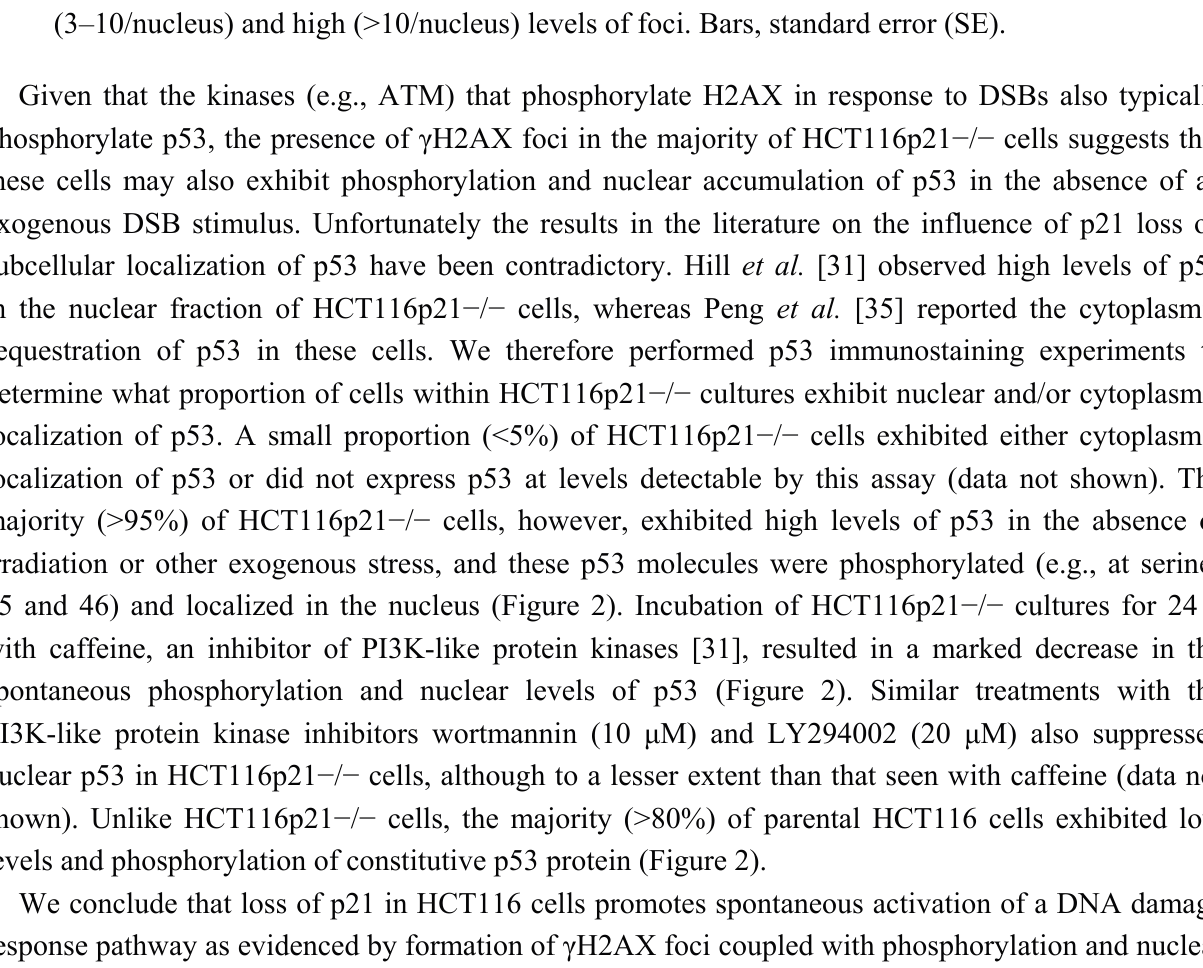
Figure 1. Influence of p21 loss on endogenous γ H2AX foci in HCT116 cells. ( A ) Representative immunofluorescence images showing constitutive γ H2AX foci in HCT116p21+/+ and HCT116p21 − / − cultures; scale bar, 10 µm; ( B ) Comparison of these cultures for the proportion of cells with low/background (<3/nucleus), moderate (3–10/nucleus) and high (>10/nucleus) levels of foci. Bars, standard error